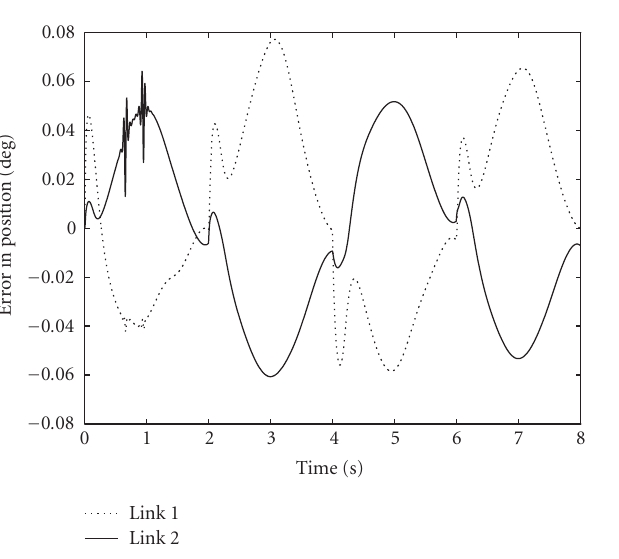
Figure 13: Errors for CDIDC + fuzzy control, trajectory